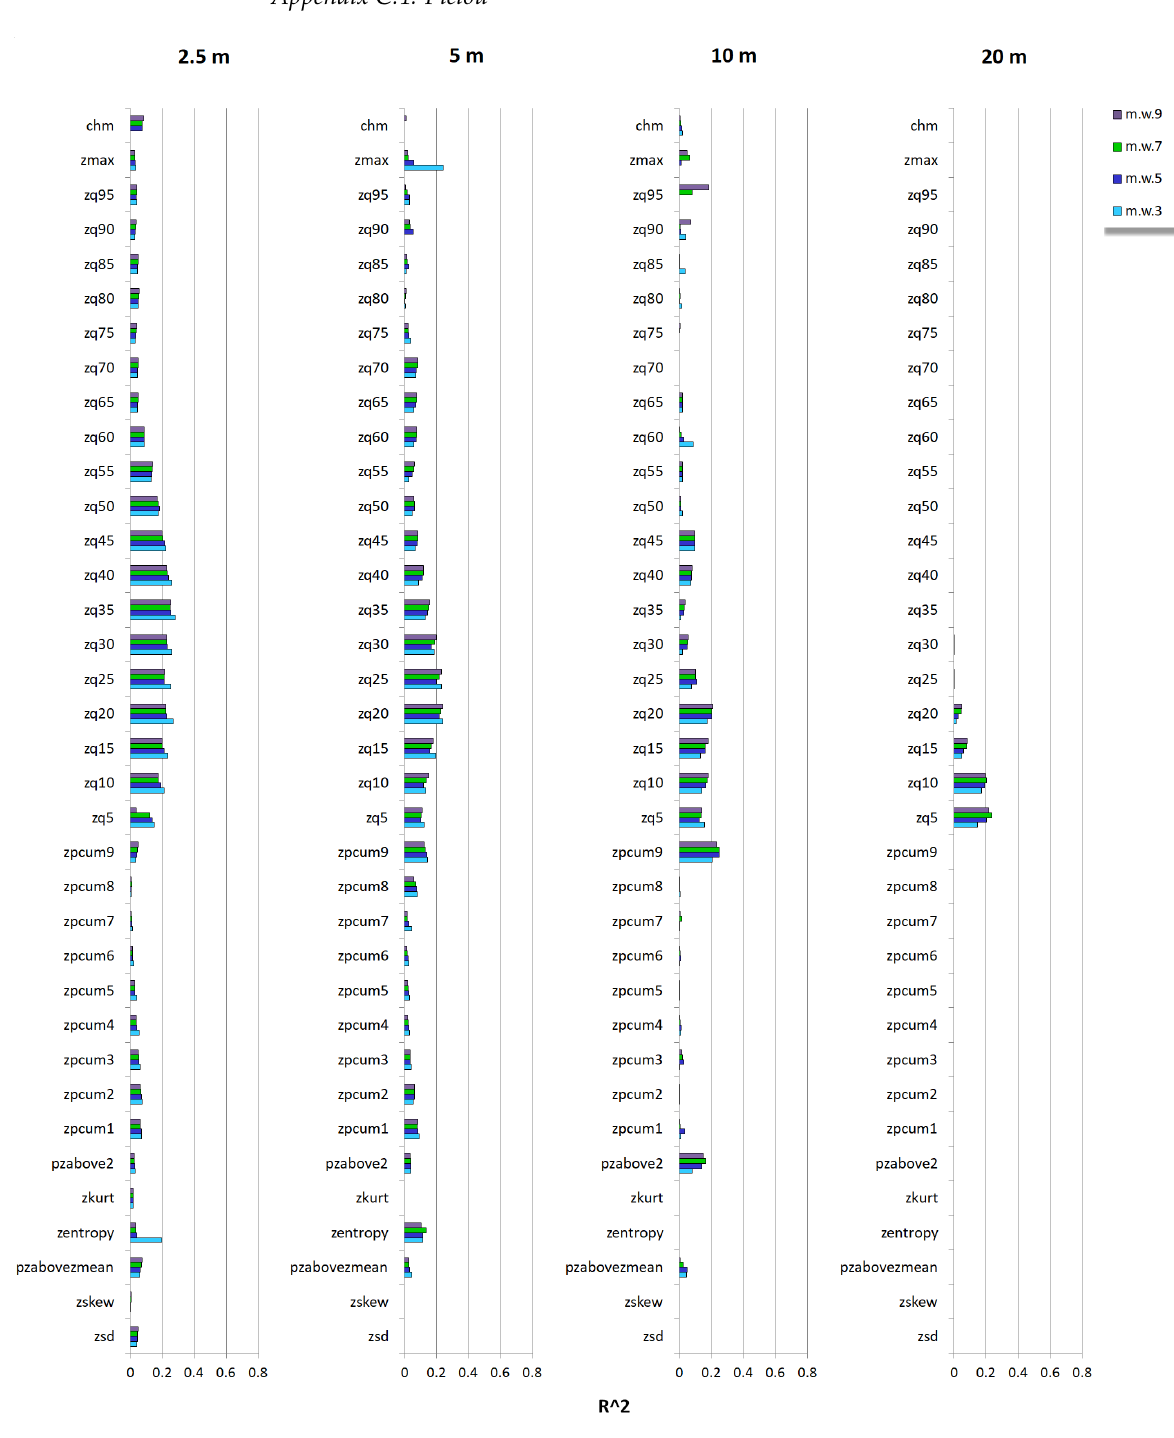
Figure A6. Histograms concerning the R 2 values relative to the linear regression between Shannon’s H field index and the mean of the Pielou’s matrices of each LiDAR metric and for each MW (San Genesio/Jenesien study